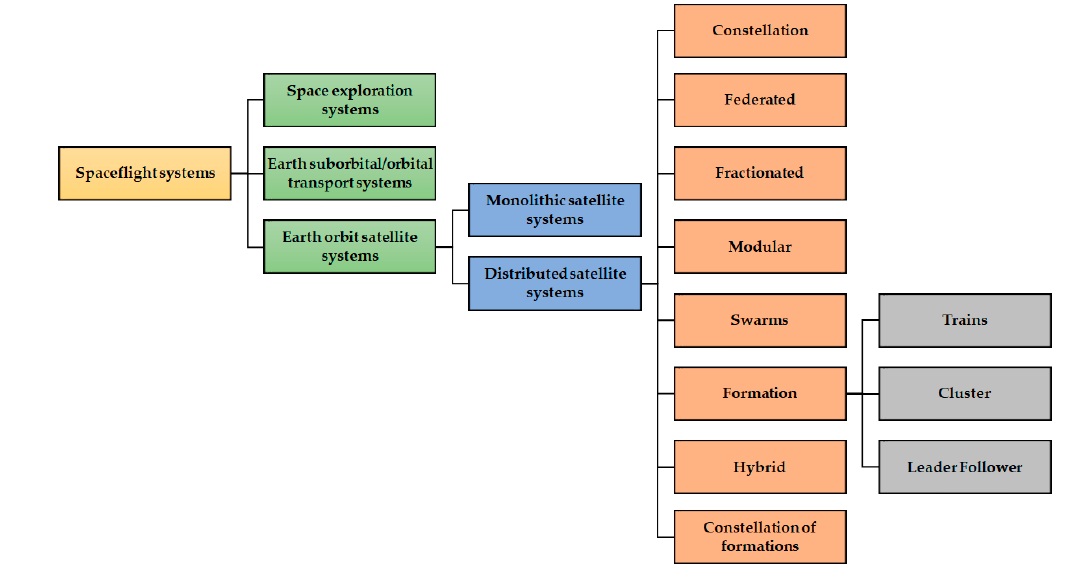
Figure 1. Classification of satellite systems. Table 1. DSS architecture types. Adapted from [24] .